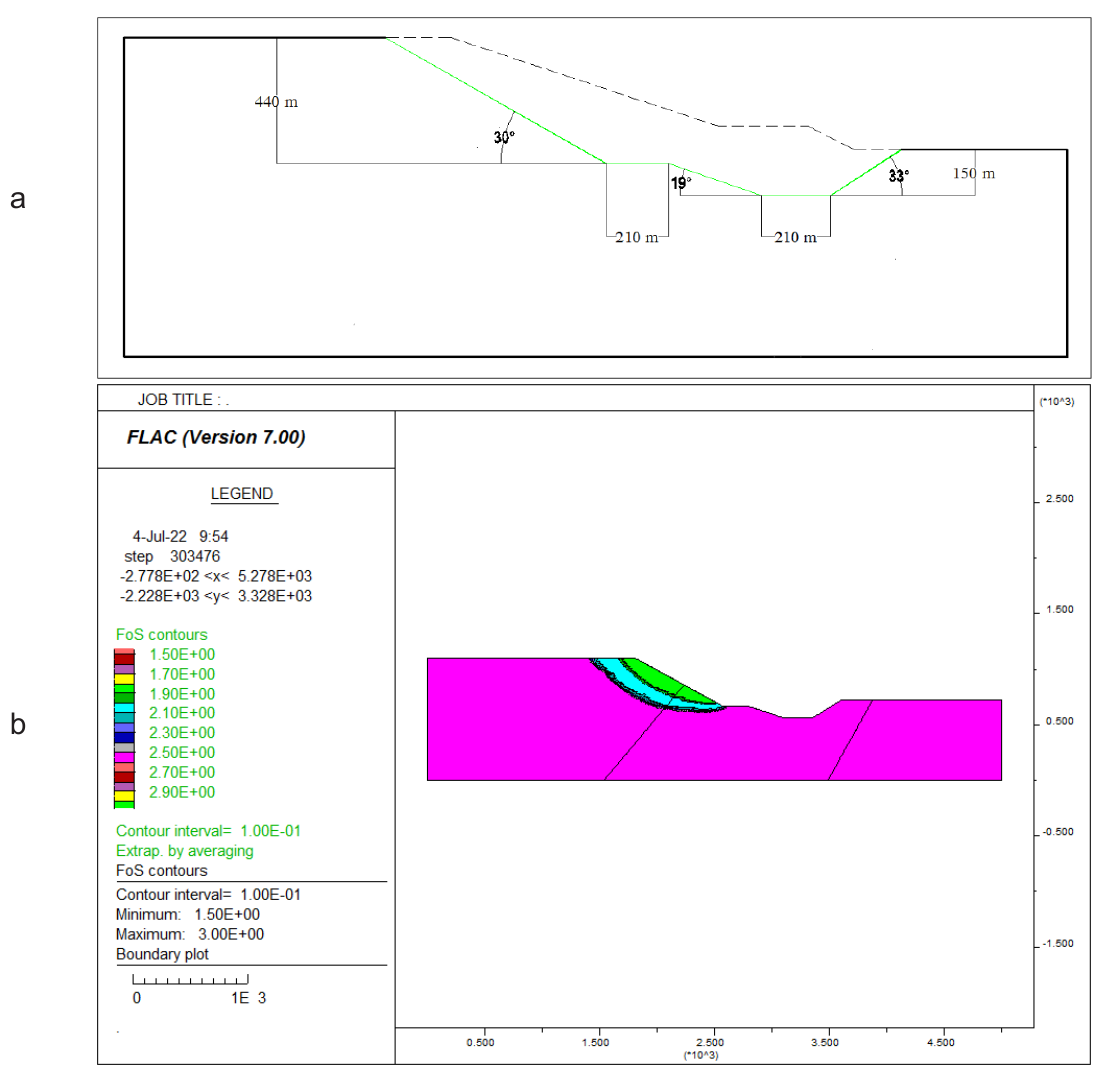
Figure 6: Pit slope in 2025: (a) scheduled geometry, (b) FoS contours and slope failure